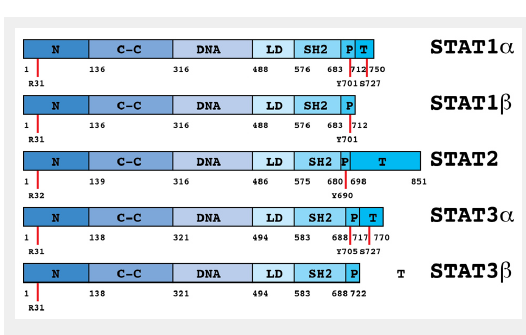
Domain structure of STATs. There are seven STAT genes in the human genome, coding for STAT1, STAT2, STAT3, STAT4, STAT5a, STAT5b and STAT6. Differential splicing and posttranslational cleavage can form multiple isoforms. For IFN signaling, STAT1 and STAT2 (and in some cells STAT3) are most important. STATs are between 750 and 850 amino acids long. All STATs share well-defined, structurally and functionally conserved domains including the amino-terminal (N), coiled-coil, DNA-binding, linker, SH2, tyrosine activation, and transcriptional activation